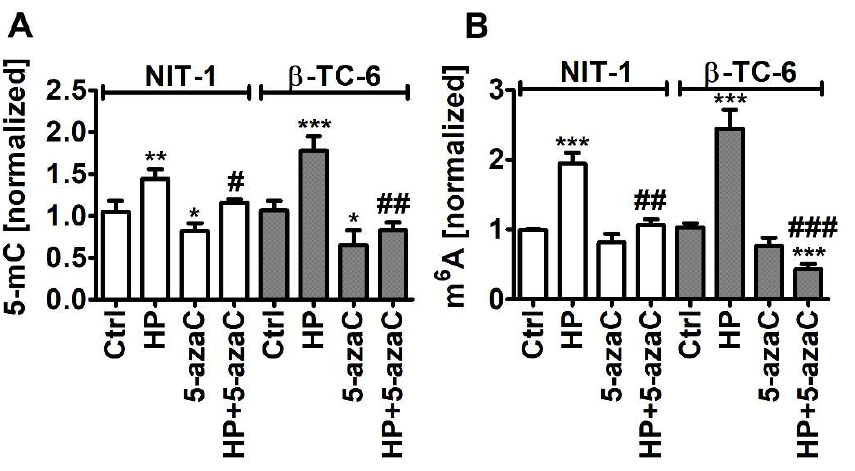
Figure 6. 5-AzaC post-treatment-mediated changes in the levels of 5-methylcytosine (5-mC) ( A ) and N 6 -methyladenosine (m 6 A) ( B ) in RNA in hydrogen peroxide-treated mouse insulinoma NIT-1 and β -TC-6 cells. Insulinoma cells were stimulated with 100 µ M HP for 24 h and then post-treated with 1 µ M 5-azaC for 24 h. The levels of 5-mC and m 6 A were investigated using dedicated enzyme-linked immunosorbent assay (ELISA). The levels of 5-mC and m 6 A were normalized to Ctrl. Bars indicate SD, n = 3, *** p < 0.001, ** p < 0.01, * p < 0.05 compared to Ctrl (ANOVA and Dunnett’s a posteriori test), ### p < 0.001, ## p < 0.01, # p < 0.05 compared to HP-treated cells (ANOVA and Tukey’s a posteriori